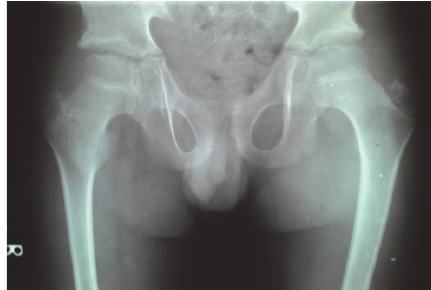
Figure 2: Anteroposterior X-ray of the pelvis showing flattened and enlarged epiphyses of the femoral heads.